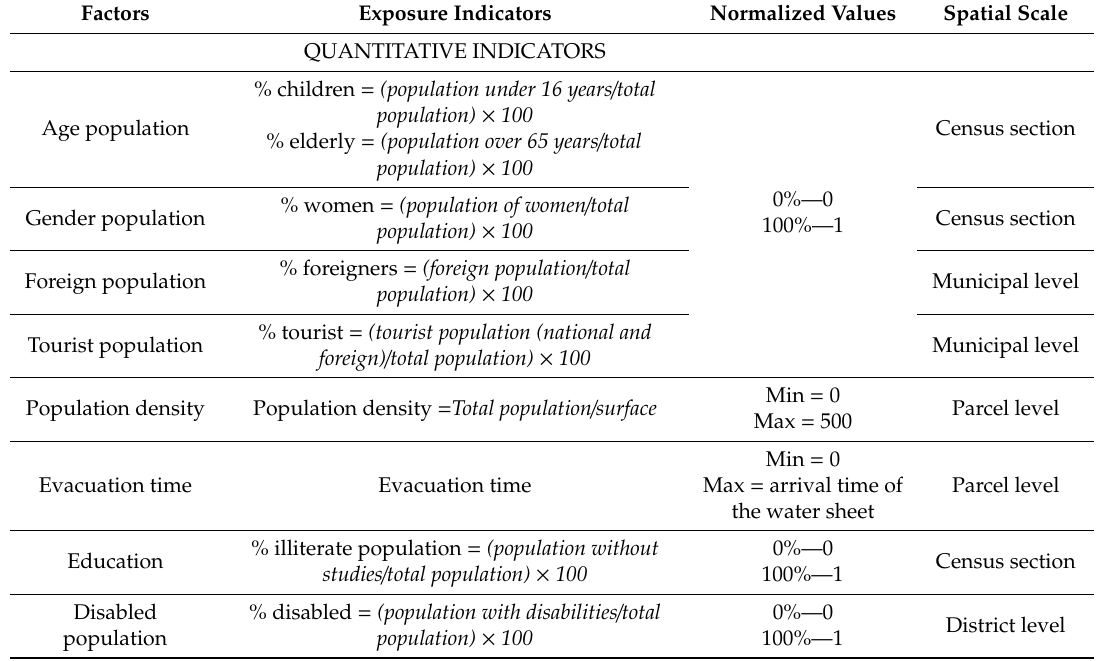
Table 1. Description of the proposed factors and indicators used to analyse the degree of exposure of social vulnerability for flood